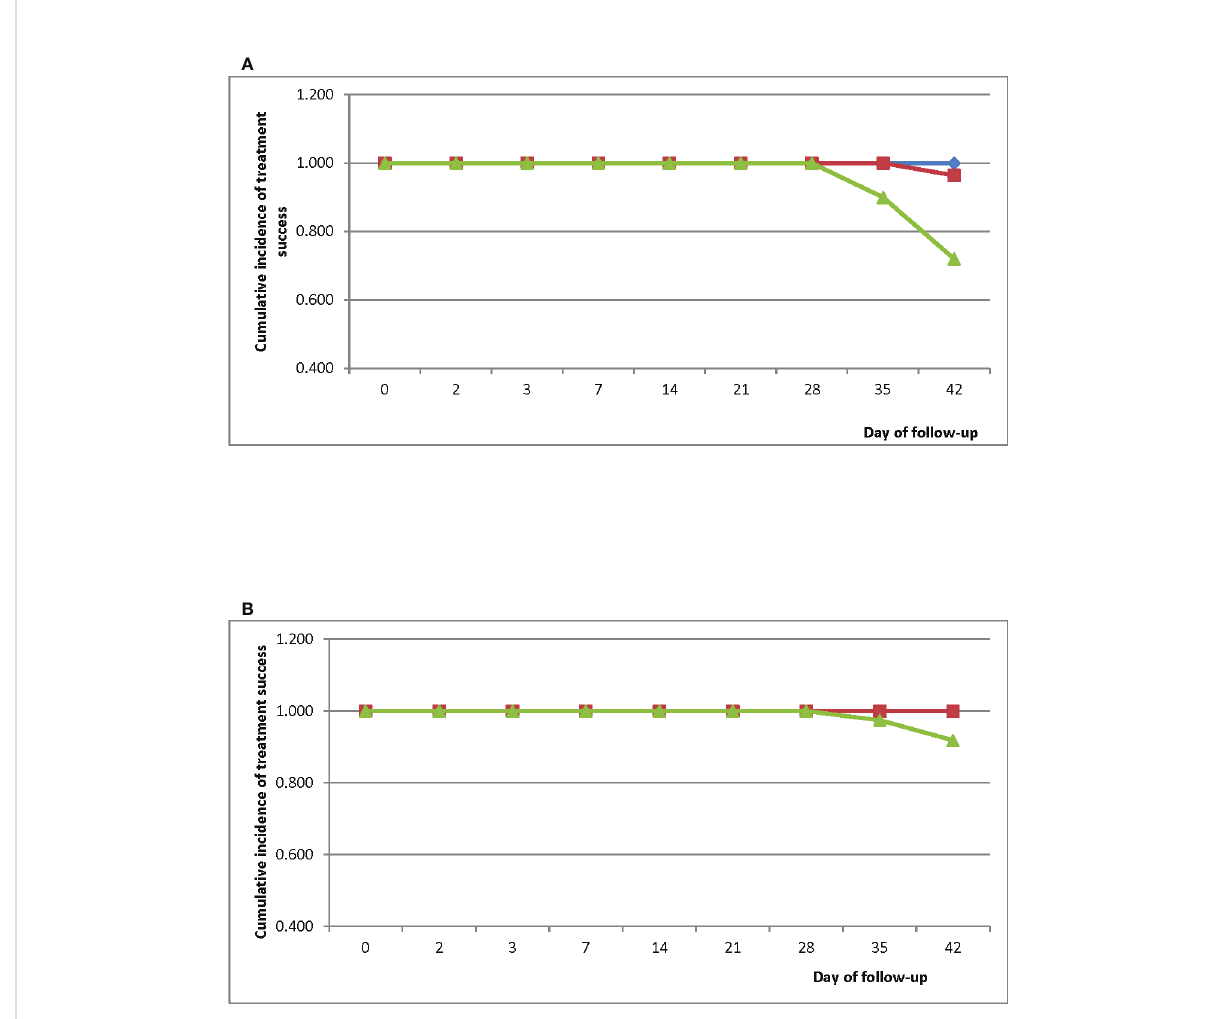
FIGURE 3 (A) PCR-uncorrected Kaplan-Meier survival curve for children treated with DHAP in three sentinel sites in Ghana. Blue line represents Hohoe Municipal Hospital (HMH); red line represents Ewim Polyclinic (EWP); and green line represents War Memorial Hospital (WMH). (B) PCR- corrected Kaplan-Meier survival curve for children treated with DHAP in three sentinel sites in Ghana. Blue line represents Hohoe Municipal Hospital (HMH); red line represents Ewim Polyclinic (EWP); and green line represents War Memorial Hospital